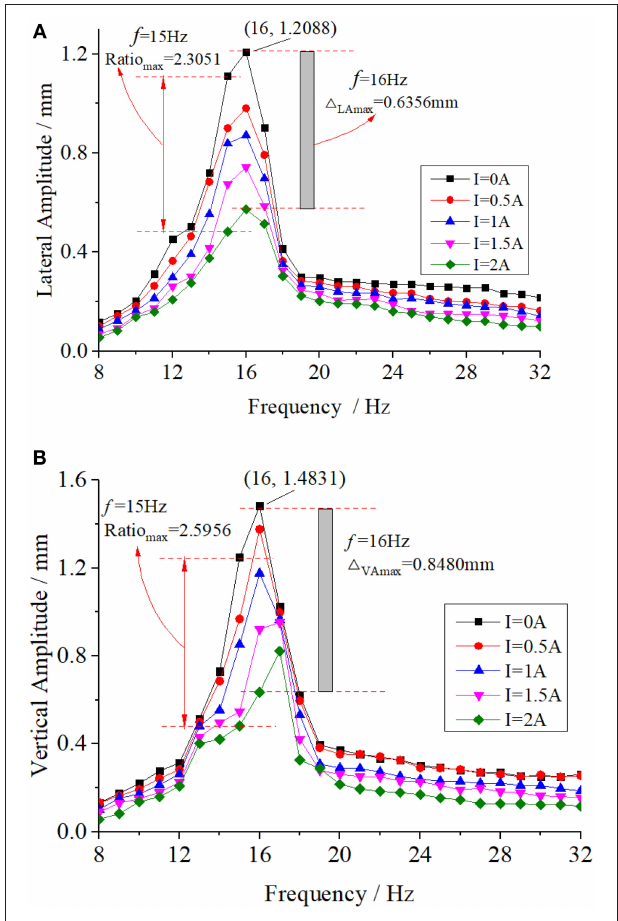
FIGURE 9 | Lateral and vertical amplitude at different excitation frequencies. (A) Transverse amplitude. (B) Longitudinal amplitude.